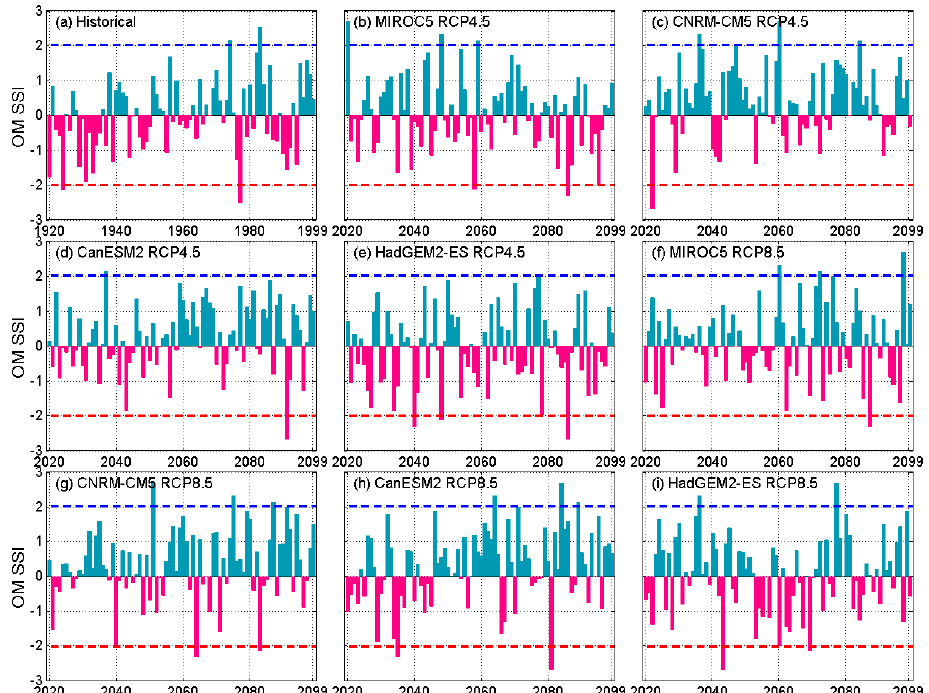
Figure A3. Historical and projected October–March SSI for SAC4. Values above the blue dash line represent extremely wet conditions while values below the red dash line indicate extremely dry conditions.